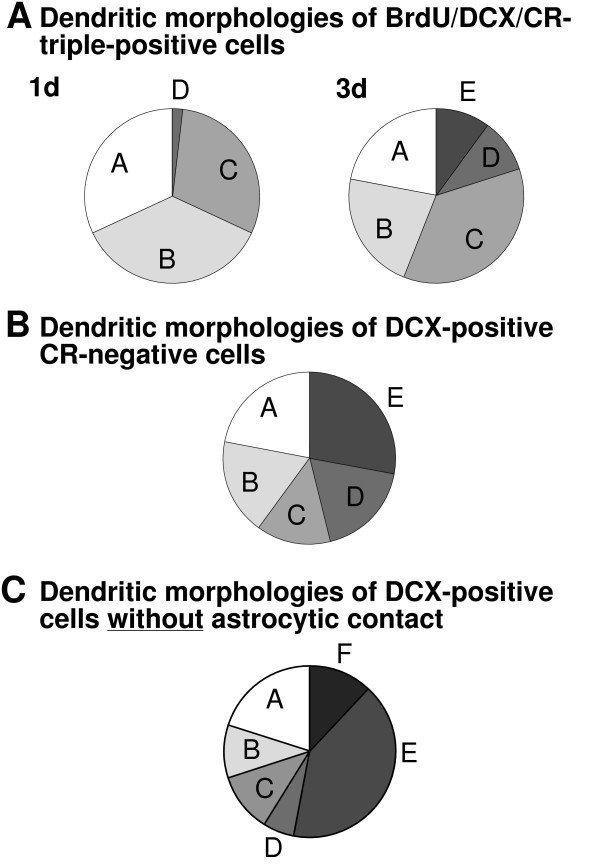
Distribution of dendritic morphologies in other subgroups of cells. A, BrdU/DCX/CR triple immunohistochemistry identifies cells that have just undergone cell division but have terminally exited from the cell cycle. Consequently, at 1 day after BrdU, these cells are found in categories A – D, two thirds in categories A and B. Two days later, about 10% have progressed to more advanced stage E. B, CR as a postmitotic marker in immature granule cells has the limitation that the onset of CR expression varies after exit from the cell cycle (cf. Fig. 3B). As a result, CR-negative DCX-positive cells can be found as late as stage E. However, they were never found in category F. C, in all categories cells without contact to astrocytes were found, but more than half of these cells were in the advanced categories E and F. If put into relation to the distribution of proliferative cells among DCX-positive cells and the absolute numbers (Fig. 4) this implies that during the early period of DCX-expression most cells have contacts with astrocytes but tend to lose this contact with increasing maturation.